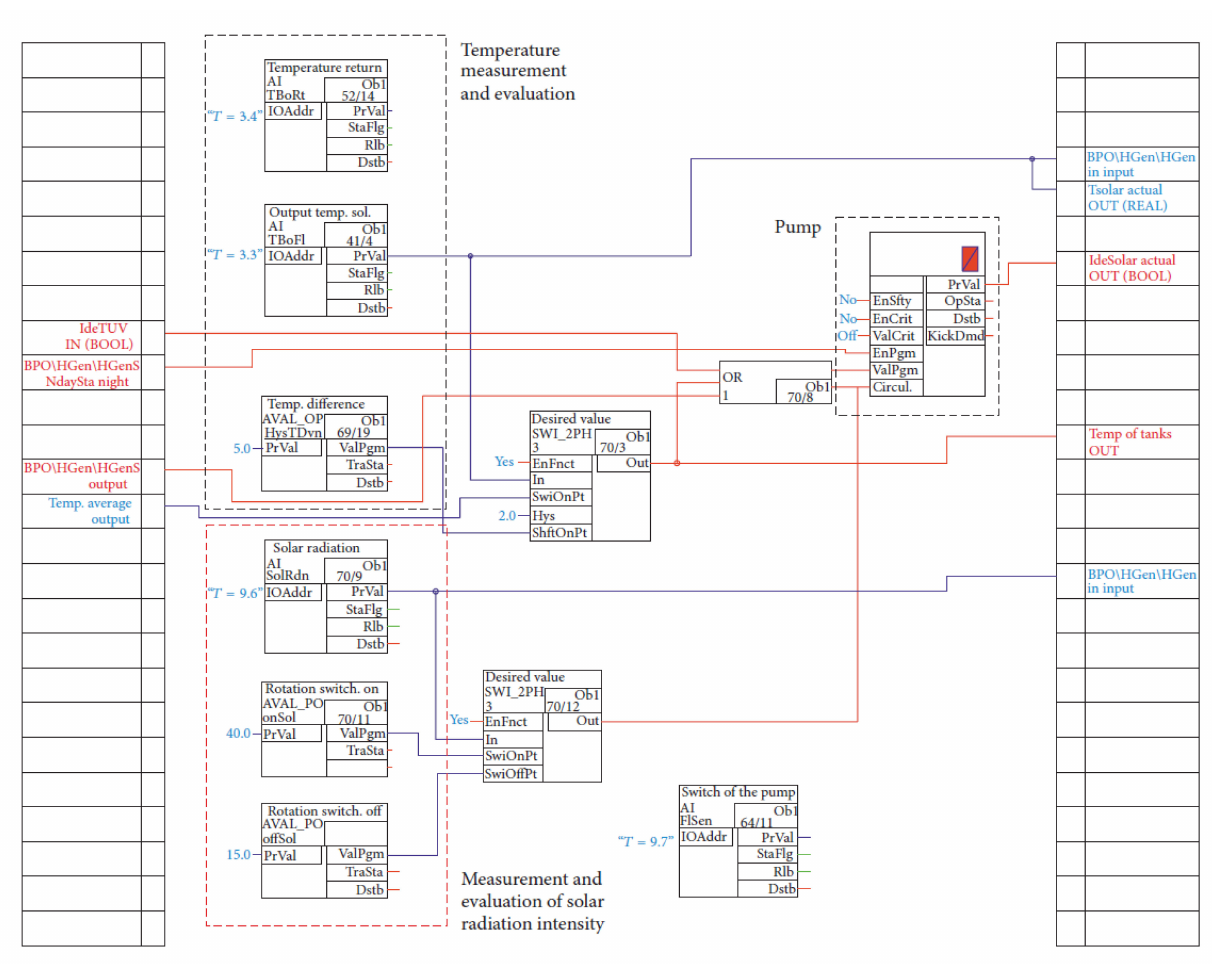
Figure 8. A diagram of the pump system control.